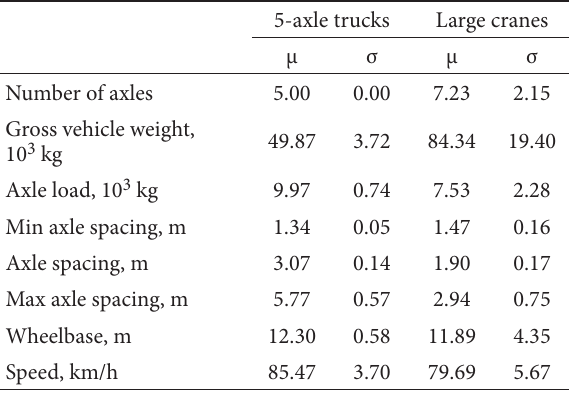
Table 1. Overview of vehicles characteristics large (mobile)